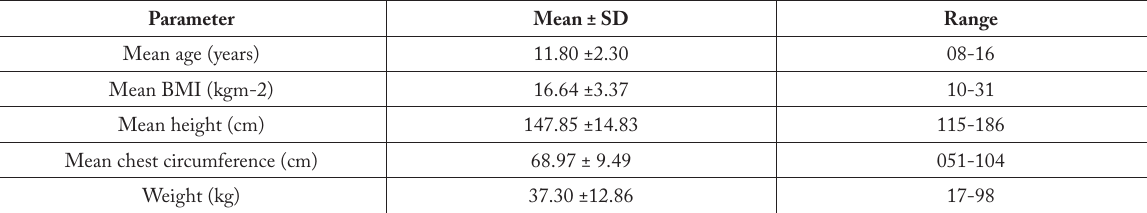
Table 1. Baseline characteristics of the study subjects.